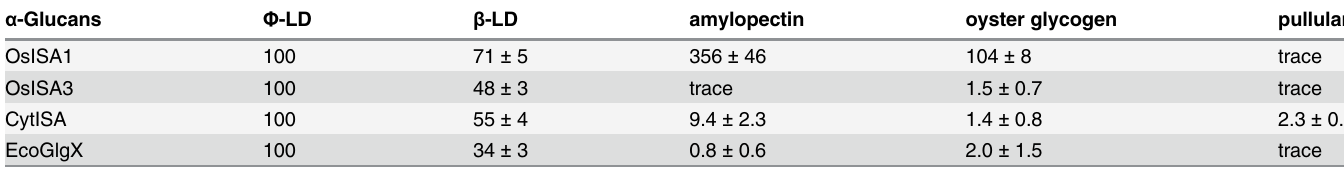
Table 1. Relative activities of glucan debranching enzymes toward various branched α -glucans. α -Glucans Φ -LD β -LD amylopectin oyster glycogen pullulan OsISA1 100 71 ± 5 356 ± 46 104 ± 8 trace OsISA3 100 48 ± 3 trace 1.5 ± 0.7 trace CytISA 100 55 ± 4 9.4 ± 2.3 1.4 ± 0.8 EcoGlgX 100 34 ± 3 0.8 ± 0.6 2.0 ± 1.5 trace Each value was the average of at least three replicate measurements. The activities of OsISA1, OsISA3, CytISA, and EcoGlgX toward Φ -LD